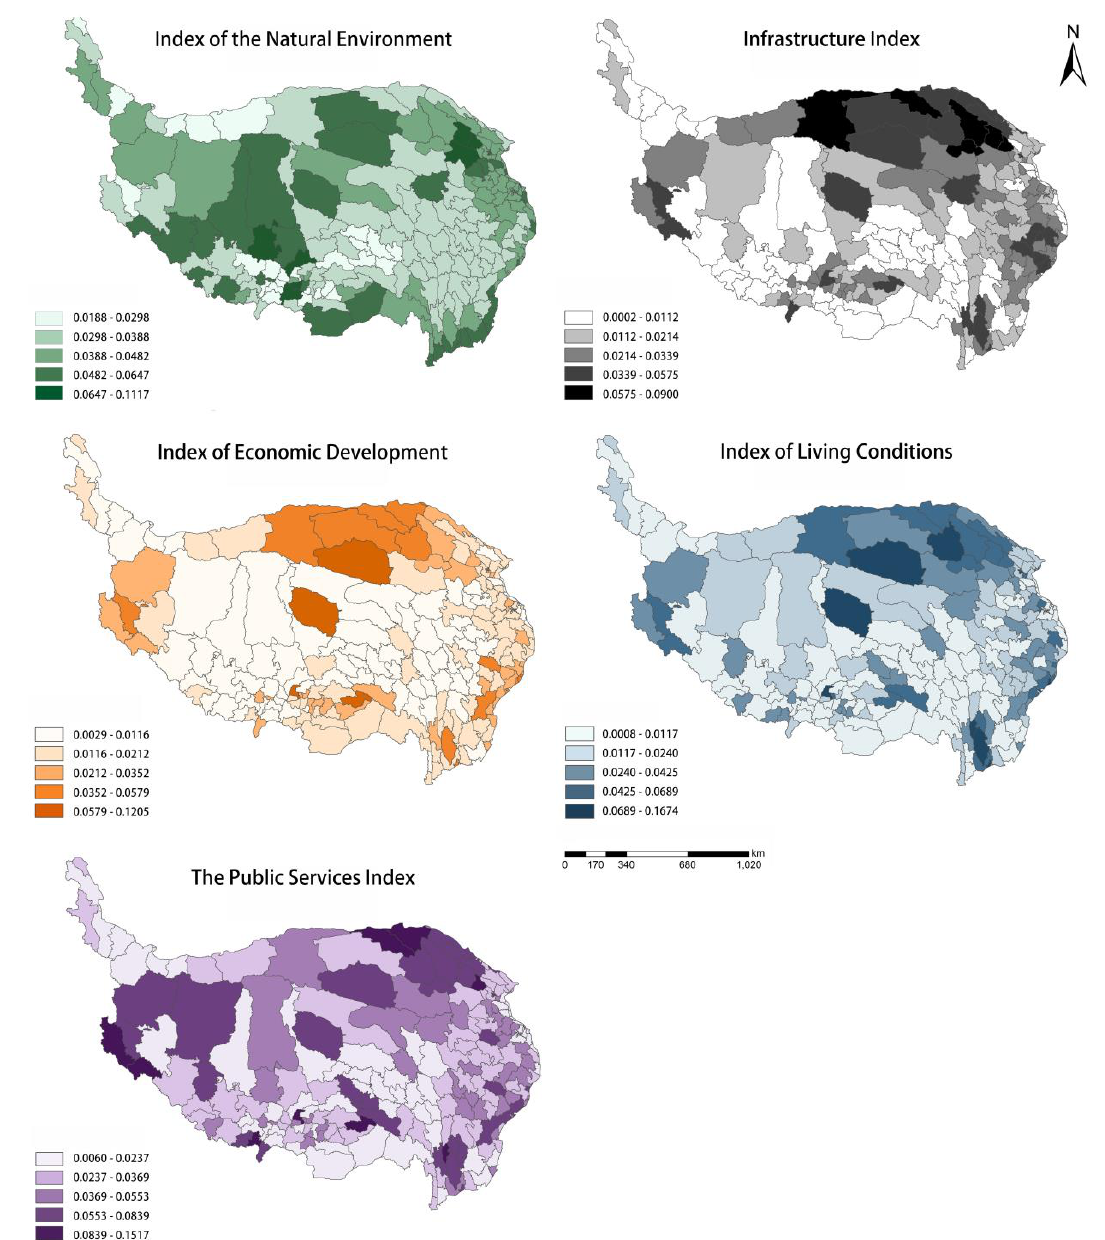
Figure 3. Spatial distribution of first-level indicators for human settlement quality in the Qinghai – Tibet Plateau. Qinghai–Tibet